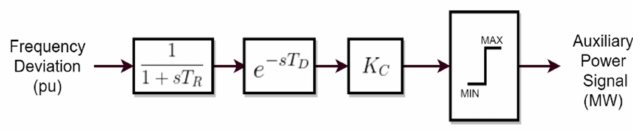
Figure 5. Frequency sensitive auxiliary power signal